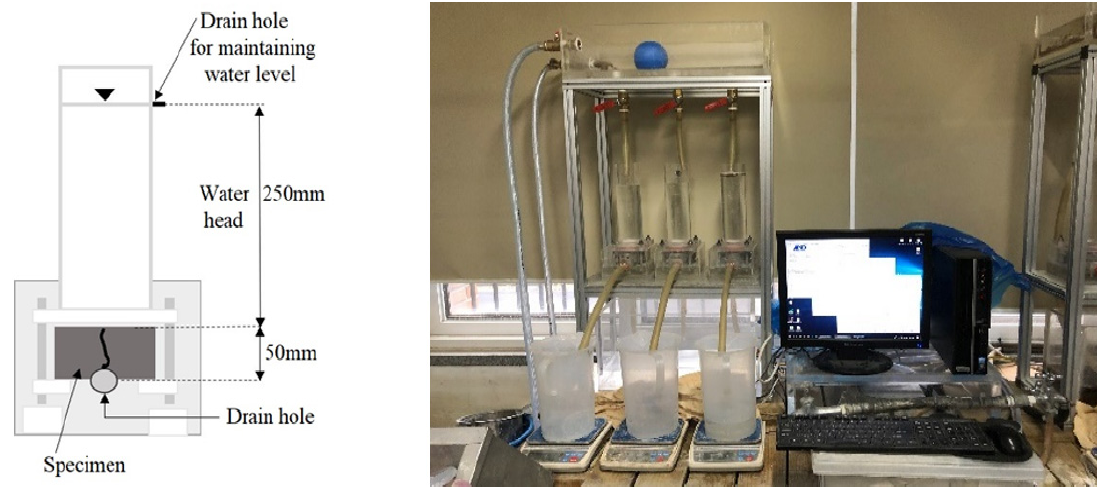
Figure 10. Water flow test.